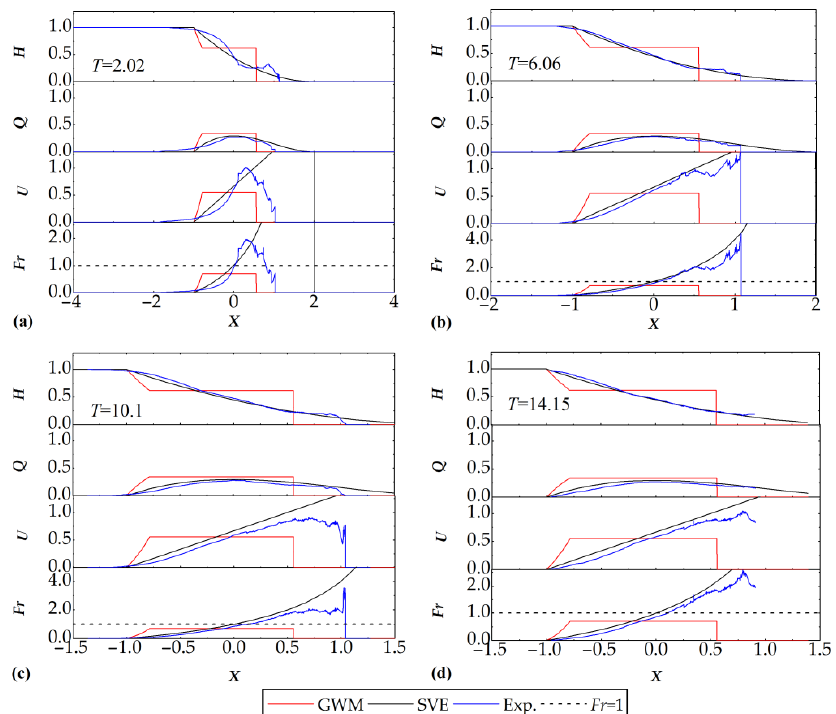
Figure 6 . Water depth, flow discharge, average velocity and Fr for dry bed downstream: ( a ) T = 2.02; ( b ) T = 6.06; ( c ) T = 10.1; ( d ) T = 14.15.